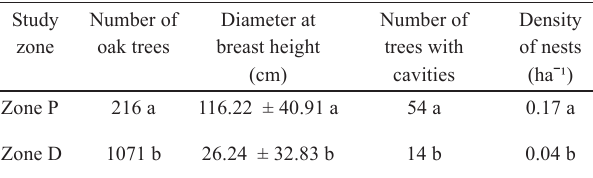
Table 1 . Number of oak trees without nests, diameter at breast height, number of trees with cavities and density of the nests in the zone preserved (P) and disturbed (D).